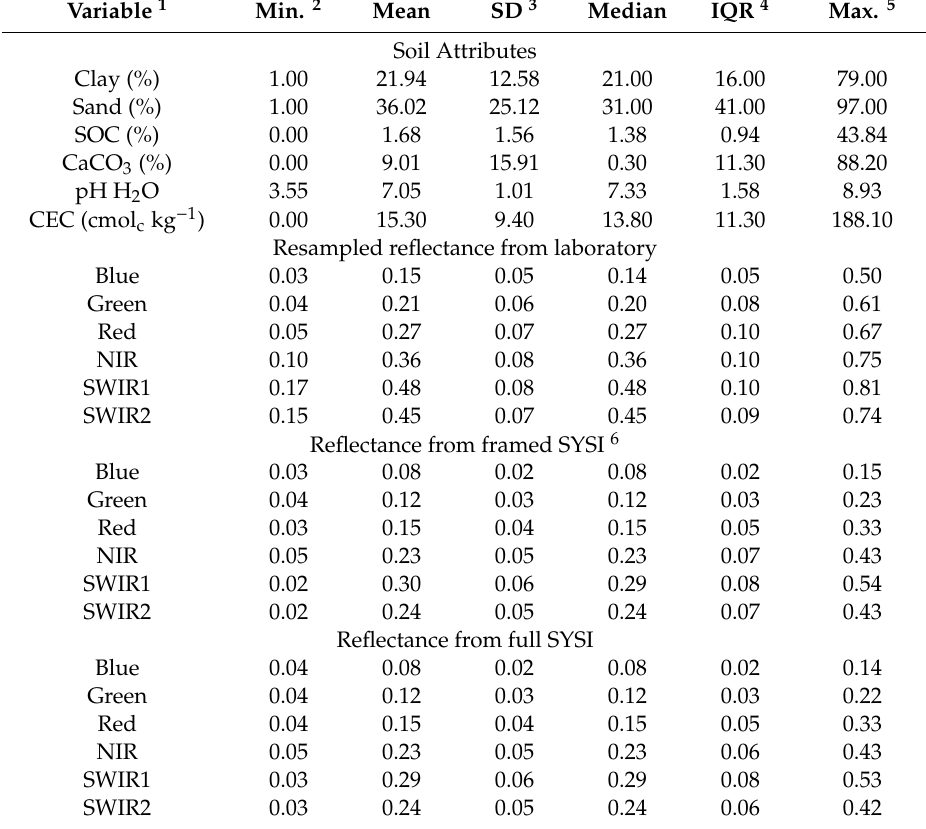
Table 1. Descriptive statistics of soil samples subset from the Land-Use / Land-Cover Area Frame Survey (LUCAS) topsoil database (n =